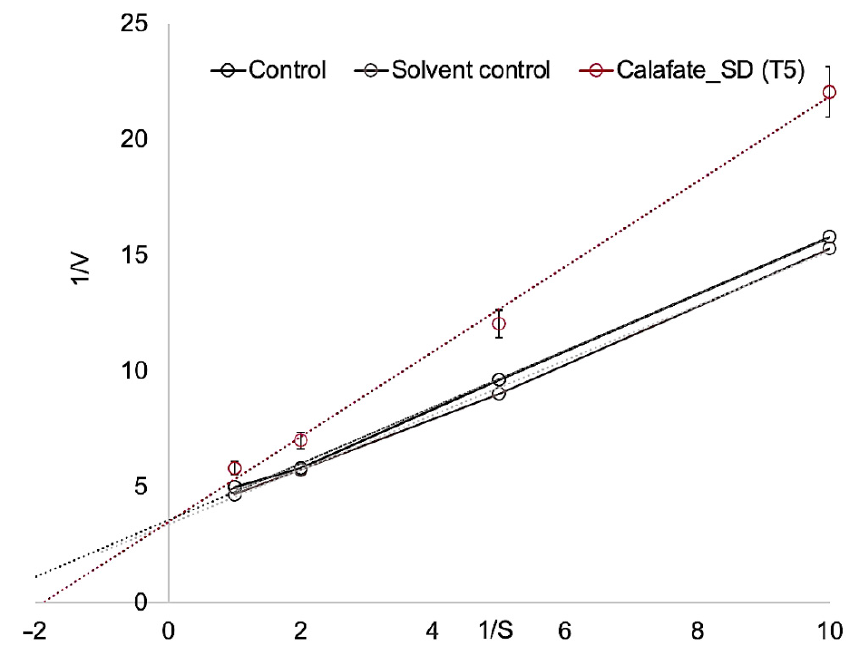
Figure 4. Acetylcholinesterase activity (AChE) of powder of calafate by Spray Drying.